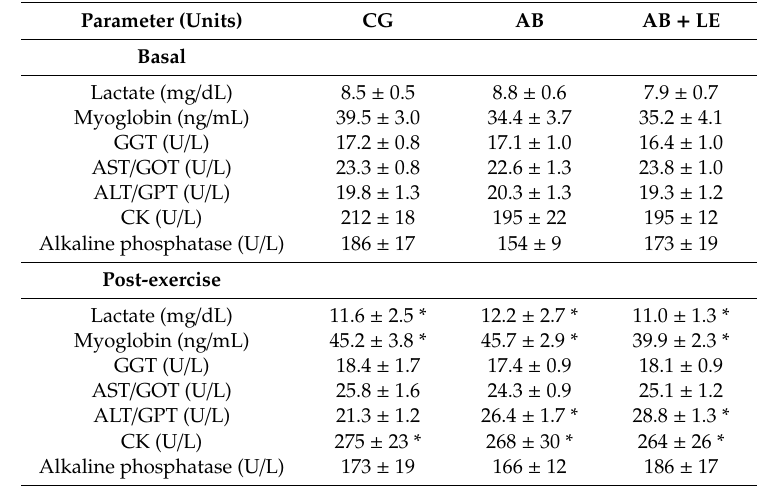
Table 3. Lactate and serum parameters related to muscle damage determined the day before the test (basal) and immediately after the 2000-m test (post-exercise) in control (CG), almond beverage (AB) and almond beverage + Lippia extract (AB + LE)